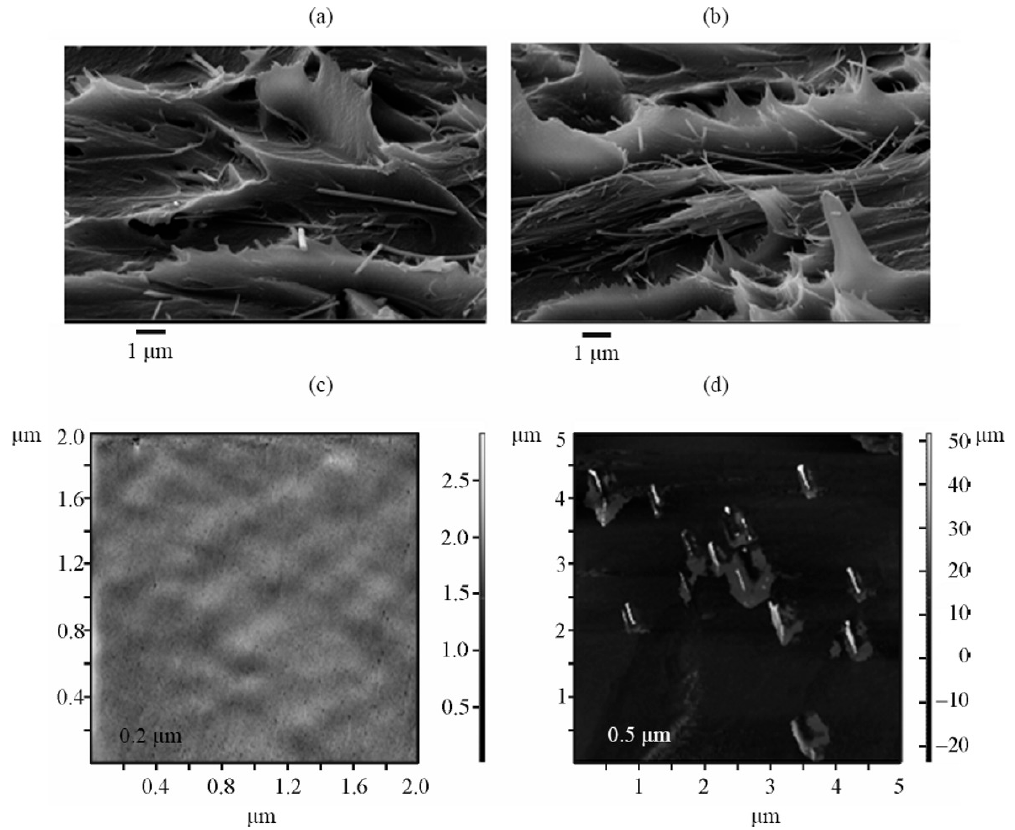
Figure 29. Visualization of the film of polyamide-imide composite with triple chain hydrosilicate: ( a , b ) the cross-section (SEM) and ( d ) phase contrast AFM; ( c ) the surface (topography mode AFM) [148].